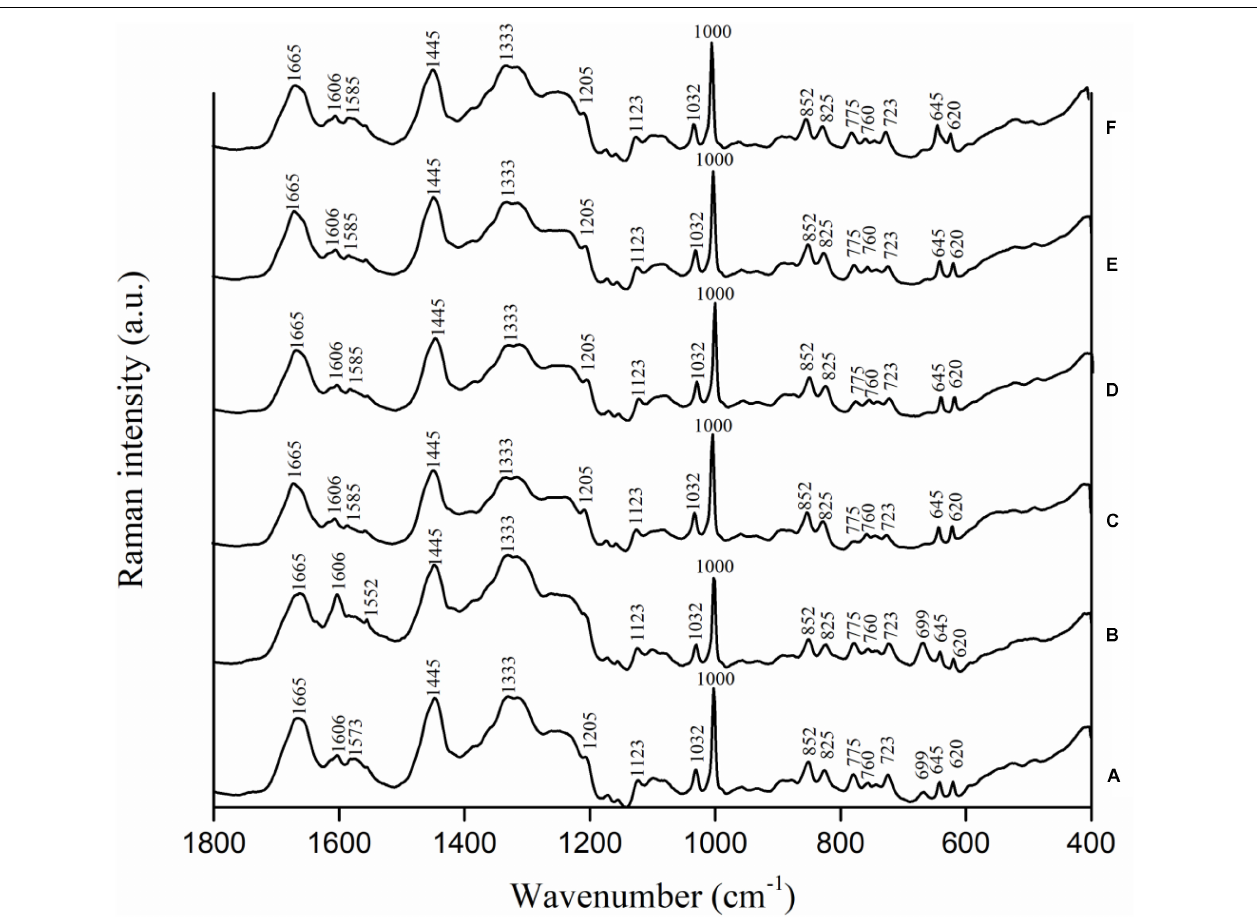
FIGURE 4 | Biochemical compositional variations of C. jejuni F38011 cells caused by antimicrobial treatments were monitored using confocal micro-Raman spectroscopy. C. jejuni F38011 cells were treated with different antimicrobials (i.e., 1 mM ajoene, 16 mM TiO 2 nanoparticles, 16 mM Al 2 O 3 nanoparticles, 0.06 mM ajoene and 4 mM TiO 2 nanoparticles, and 0.06 mM ajoene and 4 mM Al 2 O 3 nanoparticles) for 1 h at 37 ◦ C prior to Raman spectral collection. (A) Average Raman spectrum of untreated sample. (B) Average Raman spectrum of 1 mM ajoene treated sample. (C) Average Raman spectrum of 16 mM Al 2 O 3 nanoparticle treated sample. (D) Average Raman spectrum of 0.06 mM ajoene and 4 mM Al 2 O 3 nanoparticle treated sample. (E) Average Raman spectrum of 16 mM TiO 2 nanoparticle treated sample. (F) Average Raman spectrum of 0.06 mM ajoene and 4 mM TiO 2 nanoparticle treated sample ( n =